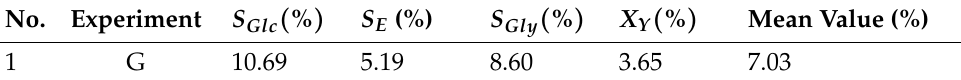
Table 7. Model validation: mean relative errors reported between model output and experimental data for fermentation without gas injection.